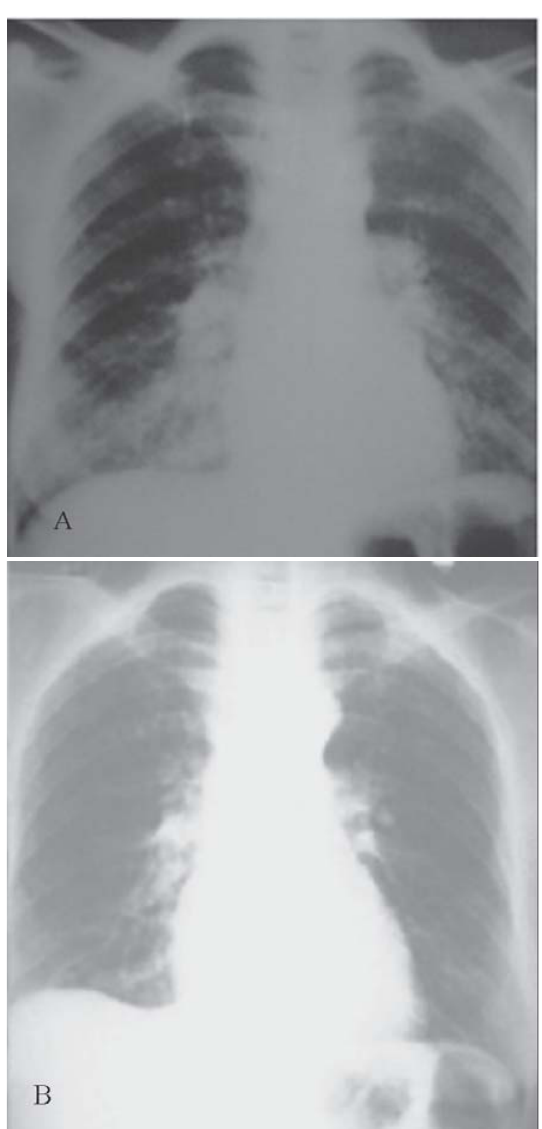
Fig. 2 - Telerradiografia de tórax. A - Pré-operatório: infiltrado pulmonar bilateral. B - Controle pós-operatório: padrão radiológico normal.